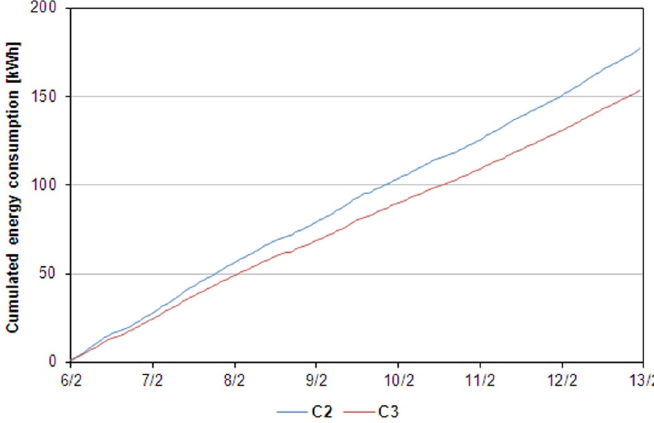
Figure 7. Energy consumption referring to the operation of the ventilated window alone, in winter.